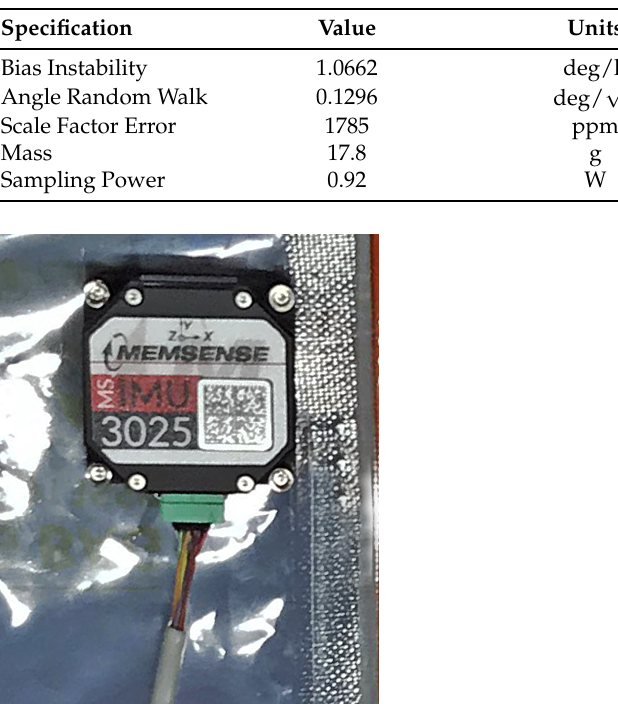
Table 2. Memsense MS3025M gyroscope specifications.